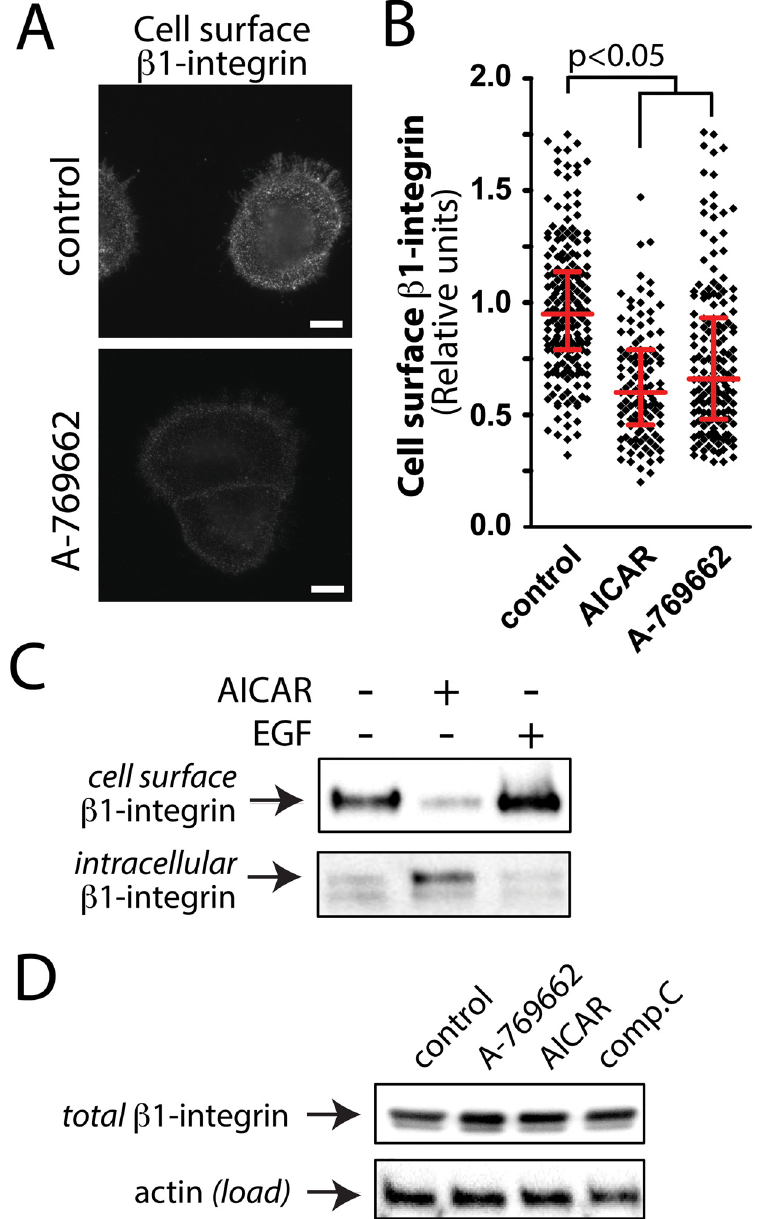
Fig 4. Treatment with A-769662 reduces cell surface β 1-integrin levels. ( A ) RPE cells were stimulated with 100 μ M A-769662 for 90 min or left unstimulated (basal). Intact cells were labeled with an antibody specific for an exofacial epitope on β 1-integrin. Shown are representative fluorescence micrographs depicting cell surface β 1-integrin fluorescence. Scale = 5 μ m ( B ) Cell surface β 1-integrin levels obtained by fluorescence microscopy were quantified as described in Materials and Methods and S5B Fig. Shown are the cell surface β 1-integrin measurements in individual cells (diamonds) as well as the median ± interquartile range of these values in each treatment condition (n = 4 independent experiments). ( C ) RPE cells were stimulated with 2 mM AICAR for 90 min or left unstimulated (basal), followed by cell-surface biotinylation, purification of biotinylated proteins and immunoblotting of fractions with an antibody specific to β 1-integrin. Shown is an immunoblot of cell surface β 1-intergin ( top panel , corresponding to the streptavidin pull-down), and of the corresponding intracellular β 1-integrin ( bottom panel , corresponding to the above supernatant), representative of 4 independent experiments. ( D ) Shown are representative immunoblots of whole-cell lysates prepared from cells stimulated with either 100 μ M A-769662, 2 mM AICAR, 40 μ M compound C (each for 90 min) or left unstimulated (control), probed with antibodies to detect total cellular β 1-integrin or actin